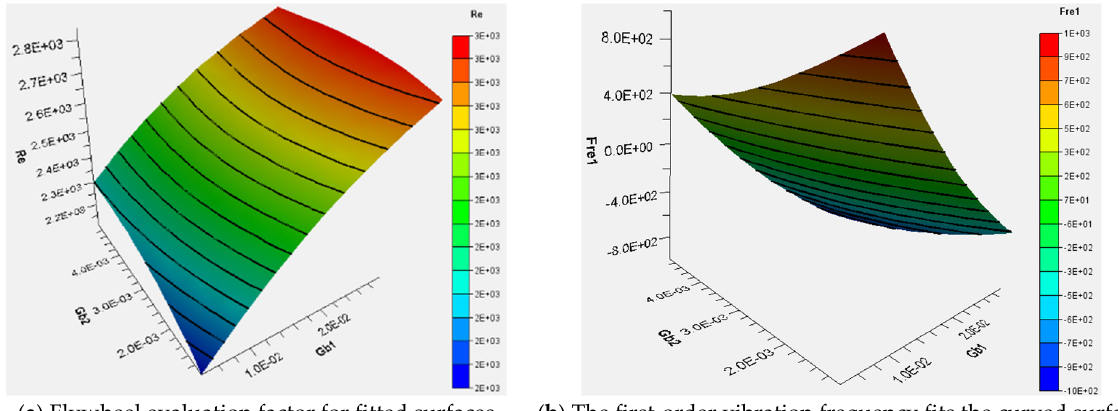
Figure 7. Target optimisation to approximate surfaces.